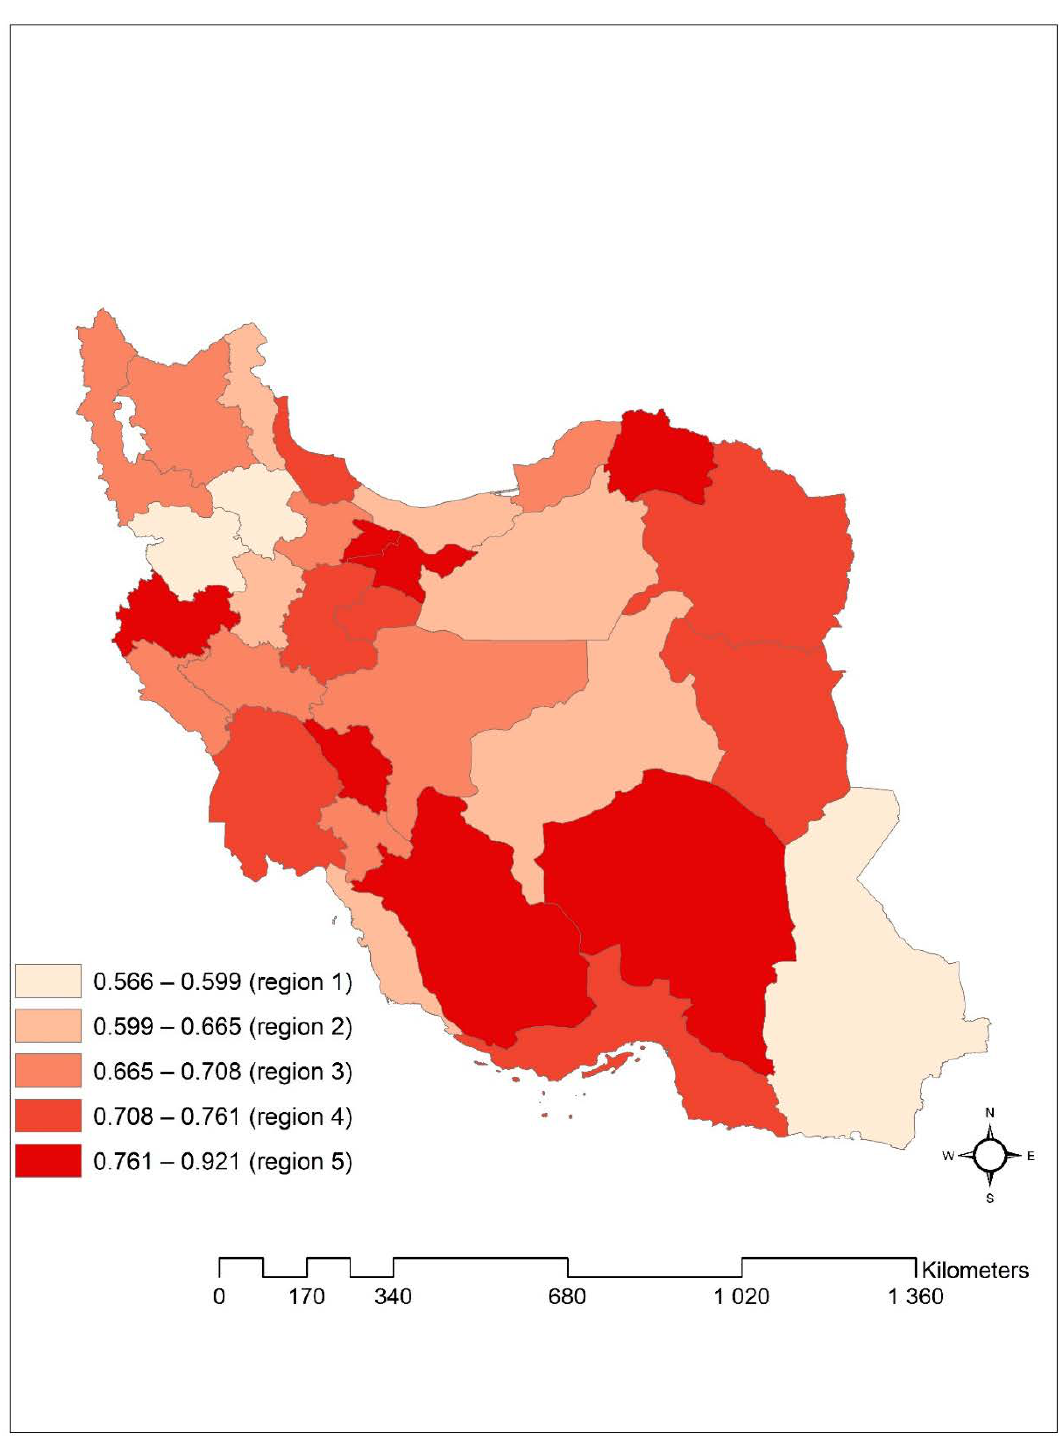
Figure 3. Posterior median of spatially correlated plus uncorrelated random effects from the log-logistic model with convolution prior, Iran provinces.